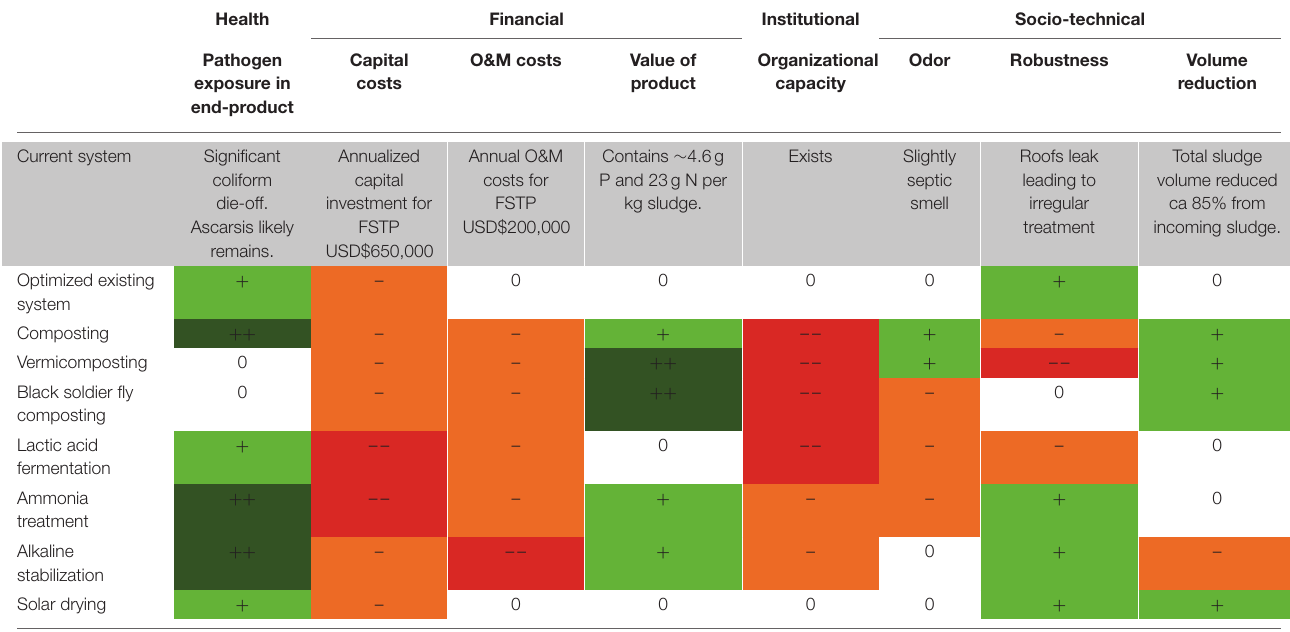
TABLE 4 | Results of the multi-criteria assessment for improving safe, nutrient-recovery from Lubigi Fecal Sludge Treatment Plant, Kampala